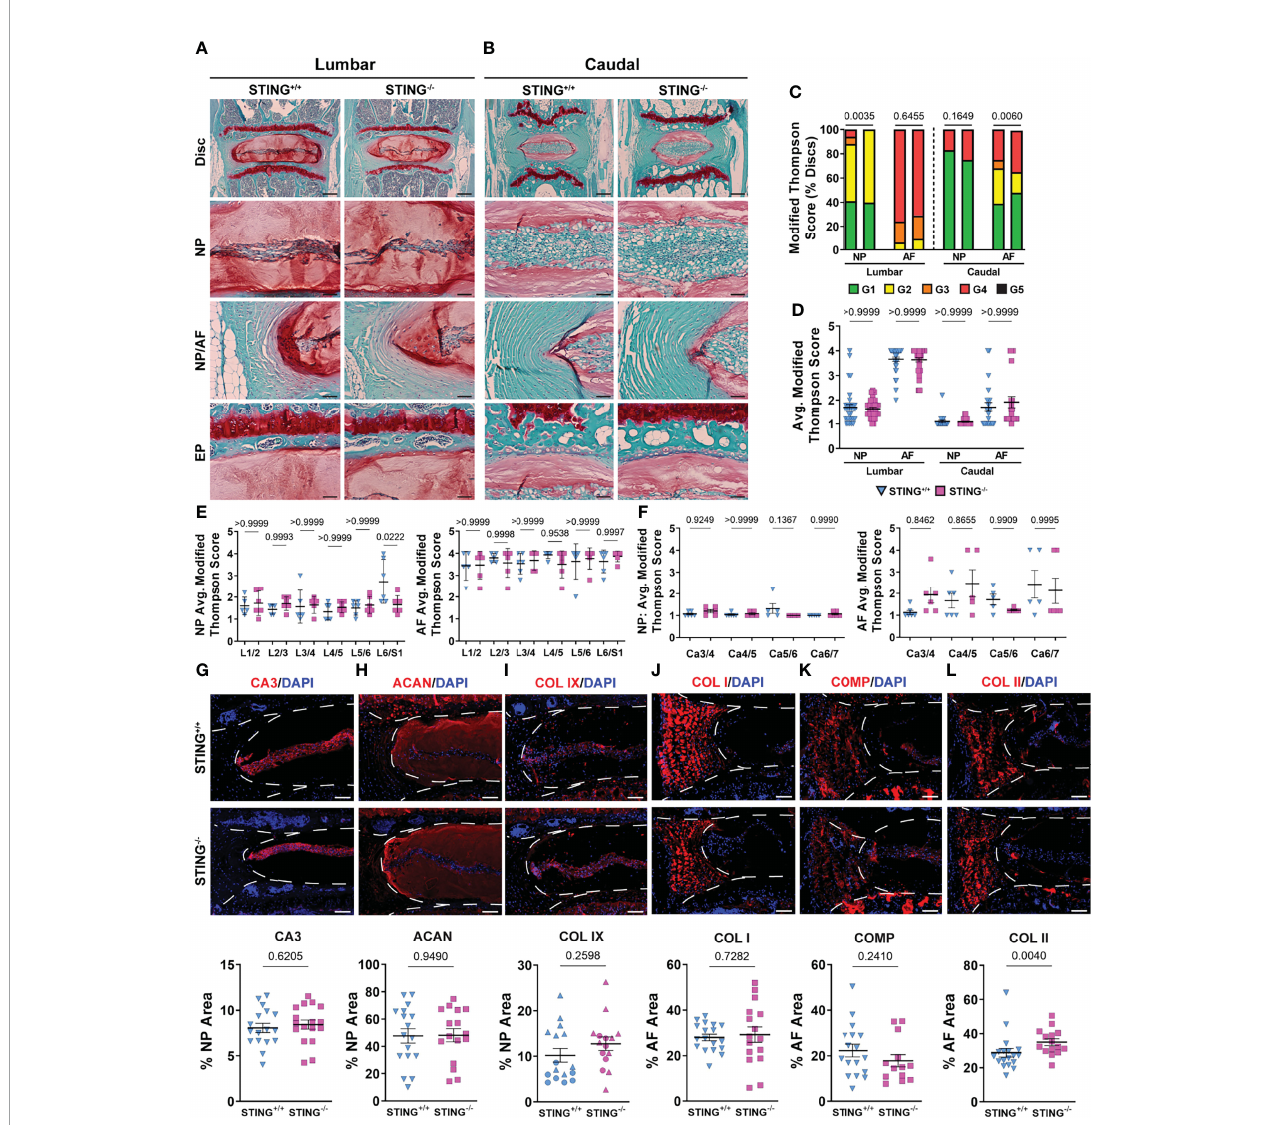
FIGURE 9 | STING -/- discs do not evidence an improved morphological or molecular phenotype. (A-B ’ ) 16-18-month-old STING +/+ and STING -/- mice were analyzed and Safranin O/Fast Green staining of (A, A ’ ) lumbar and (B, B ’ ) caudal discs shows tissue morphology and proteoglycan content (row 1, scale bar= 200 m m) and high magni fi cation images of the NP, EP, and NP/AF tissue boundary (rows 2-4, scale bar= 50 m m) are shown. (C – F ’ ) Histological grading assessment using the modi fi ed Thompson scale for (E, E ’ ) lumbar and (F, F ’ ) caudal discs (n = 5 lumbar discs/animal, 4 caudal discs/animal, 6 animals/genotype, 30 lumbar and 24 caudal discs/genotype). (C) Distribution of and (D) average histological grades in the NP and AF, with higher scores indicating higher levels of degeneration. (E, F ’ ) Level-by-level average grades of NP and AF degeneration. (G – L ’ ) Quantitative immunohistological staining conducted on lumbar discs for (A, A ’ ) CA3, (B, B ’ ) ACAN, (C, C ’ ) collagen IX (COL IX), (J, J ’ ) COL I, (K, K ’ ) collagen oligomeric matrix protein (COMP), and (L, L ’ ) collagen II (COL II). (n = 2-4 discs/animal; 6 animals/genotype, 12-24 total discs/genotype) Dotted lines demarcate different tissue compartments within the disc. Signi fi cance for grading distribution was determined using a c 2 test. Signi fi cance of average and level-by-level scores and quanti fi ed immunohistochemistry was determined using an unpaired t-test or Mann- Whitney test, as appropriate. Quantitative measurements represent mean ±